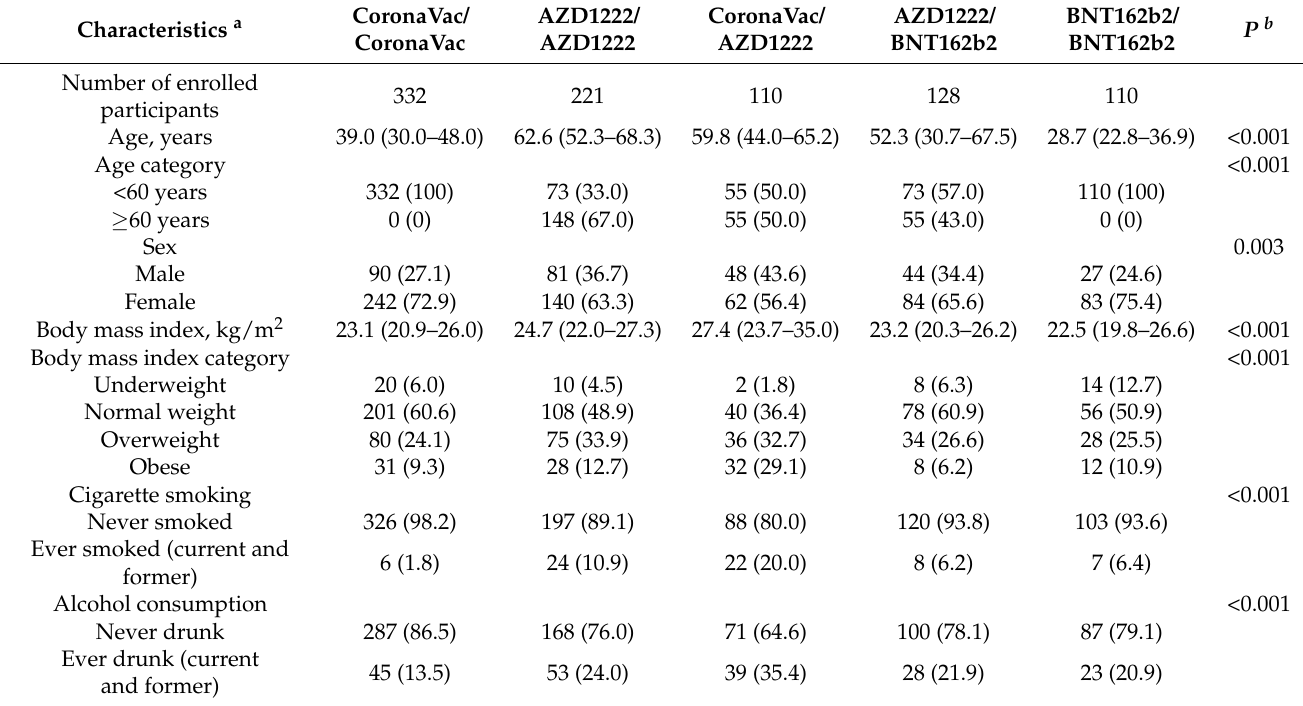
Table 1. Characteristics of study participants, stratified by the COVID-19 vaccine